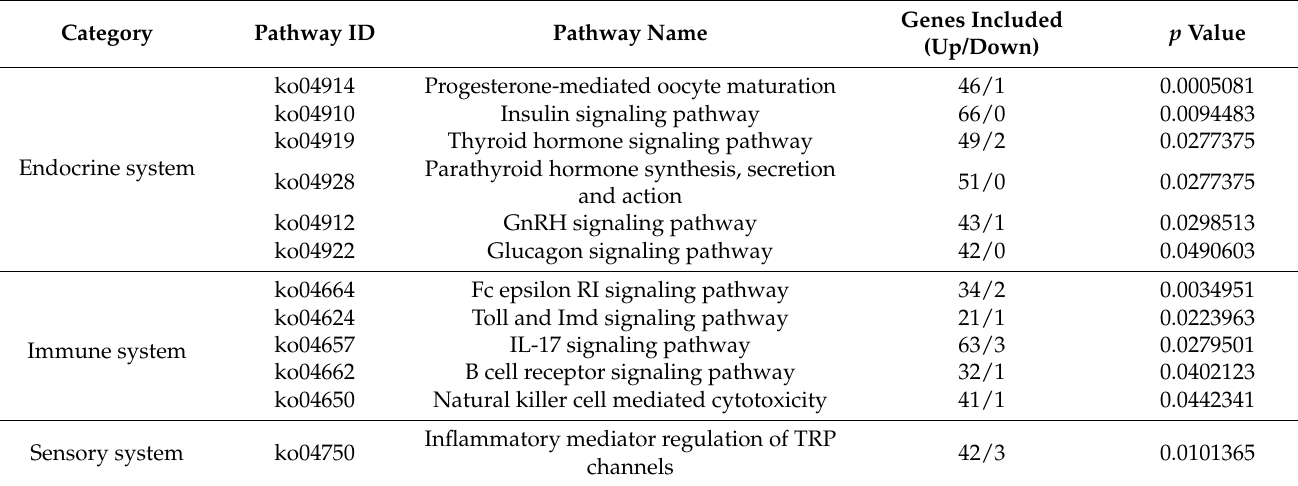
Figure 2. KEGG enrichment analysis of DEGs and heatmap of key genes. ( A ) 43 KEGG pathways significantly enriched. ( B ) The heatmap of key genes. Red means up-regulating, blue means down- regulating, the shade of color means degree of regulating. Table 2. The enrichment results of several key KEGG